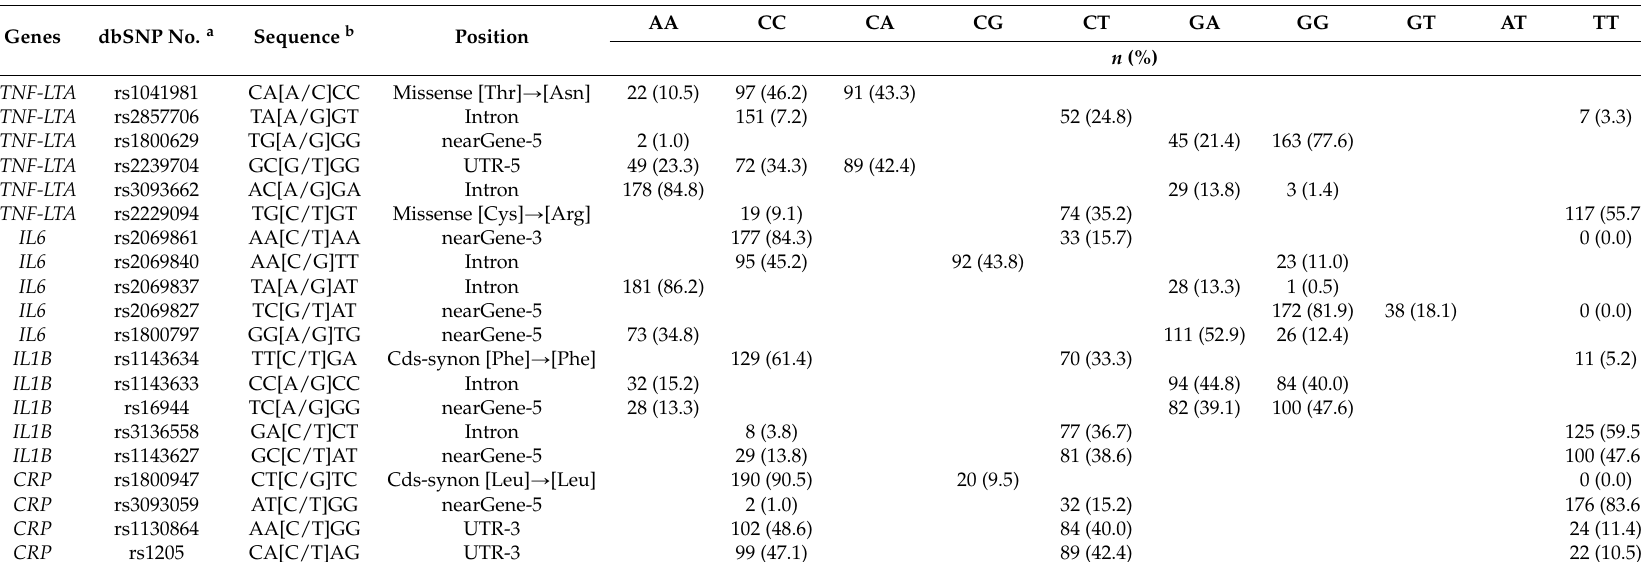
Table 4. Selected SNPs within TNF-LTA , IL-6 , IL-1 β , and CRP